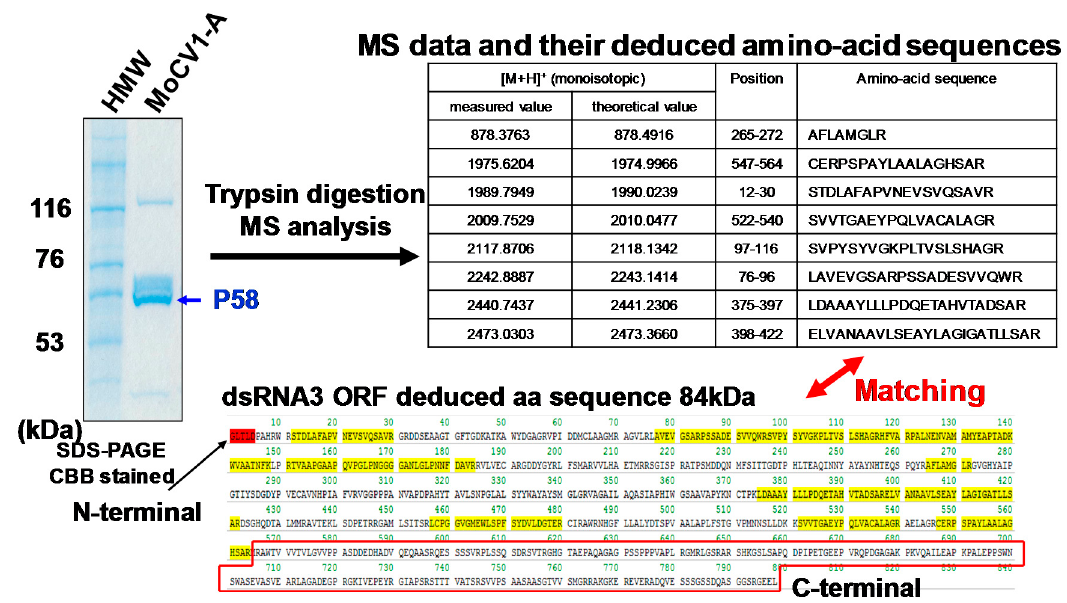
Figure 5. Determination of the C-terminal residue of the MoCV1-A 60 kDa protein (labeled P58 in the figure). The C-terminus of P58 is a truncated version of the ORF3 protein missing 200 amino acids. Mass spectrometry of tryptic peptides derived from P58 identified peptides specific to the deduced amino acid sequence of ORF3, but no peptide sequence mapped to the C terminus of the deduced amino acid sequence of ORF3 (M565 to